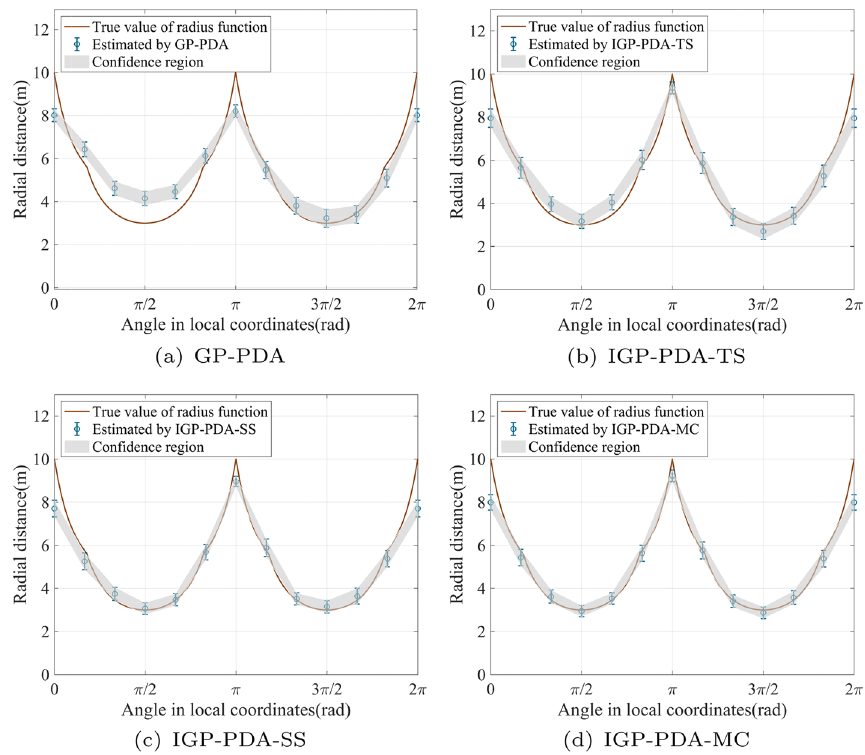
Fig. 10 True radius function and estimates error bar using different methods in the second scenario